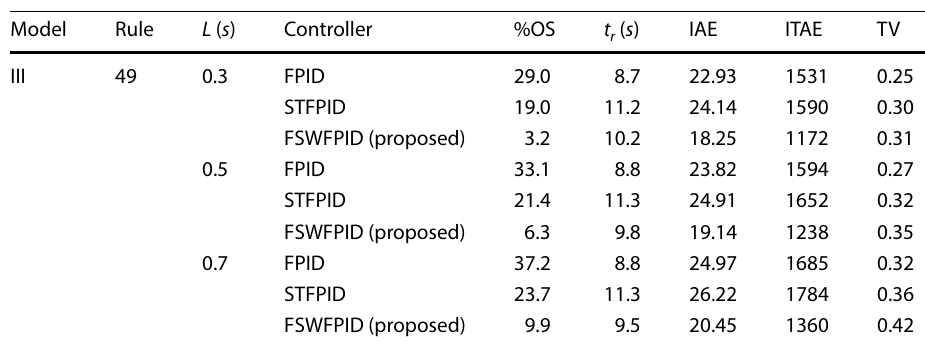
Table 9 Performance analysis for Model